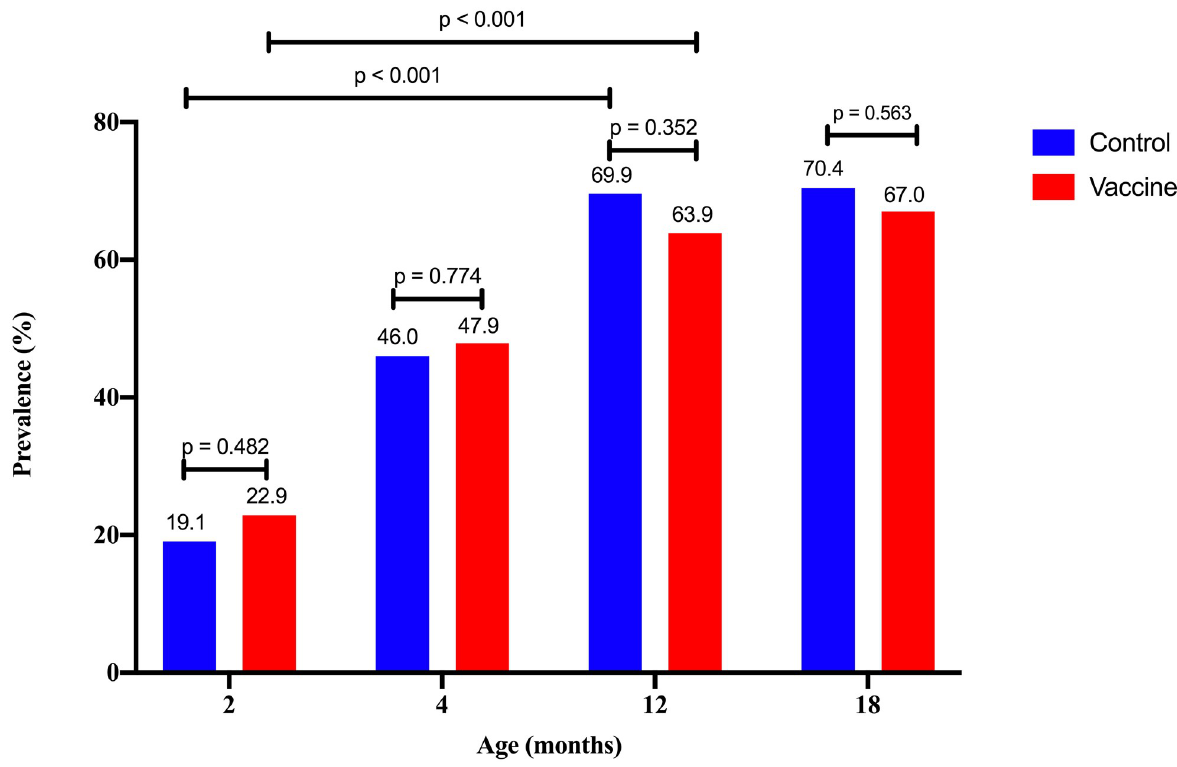
Fig 2. The prevalence of S . pneumoniae -positive subjects by age in control and vaccine